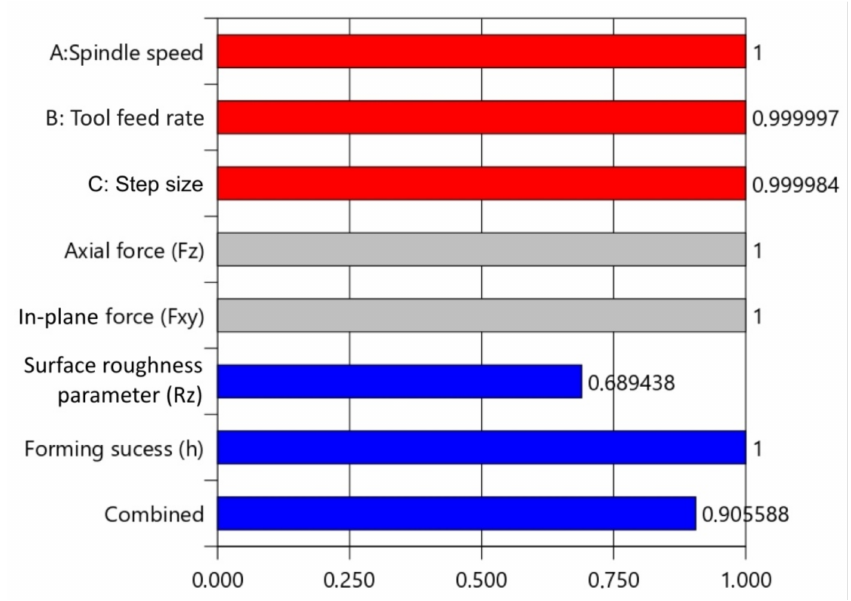
Figure 16. Desirability plot of the most favourable solution.